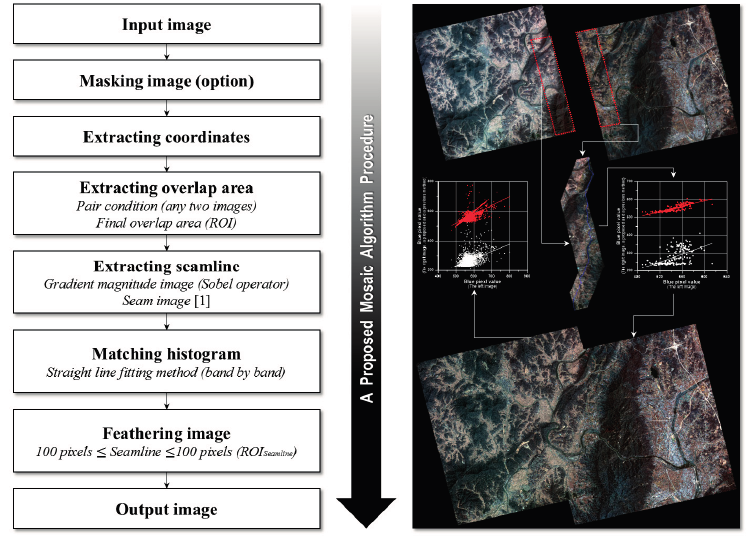
Figure 2. Flowchart of the proposed mosaic algorithm